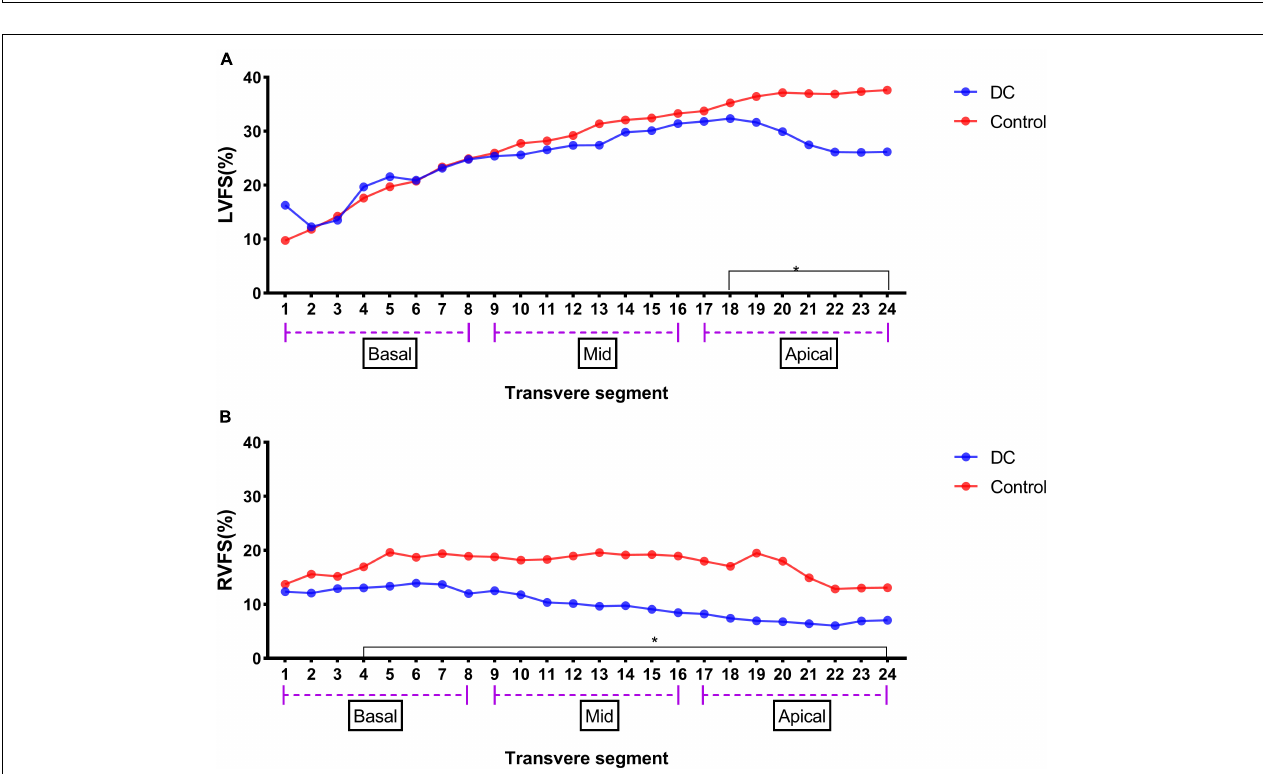
FIGURE 2 | LV 24-segment FS in the DA constriction group and the control group (A) and RV 24-segment FS in the DA constriction group and the control group (B) . * p < 0.05 compared in DC group and control group.